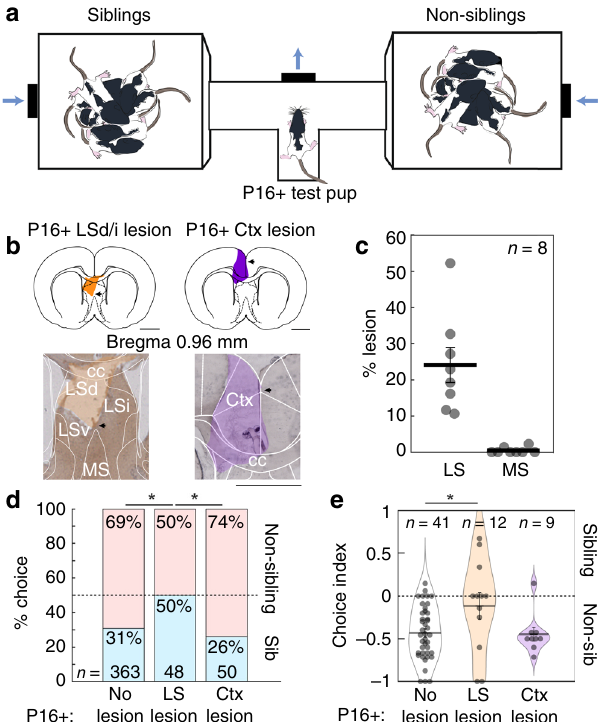
Fig. 3 Non-sibling preference of old pups is disrupted by lesion of the lateral septum. a Apparatus for sibling-preference testing. Test pup was placed in the T-tube with two opposing chambers containing sibling and non-sibling rats. Air was blown toward the center of the T-choice tube. b Examples of two sections from two pups with lateral septal and cortical lesions (LS: lesion area in orange, Ctx: lesion area in purple). Scale bar applies to left and right micrographs. c Sections (100 µ m thickness) of eight